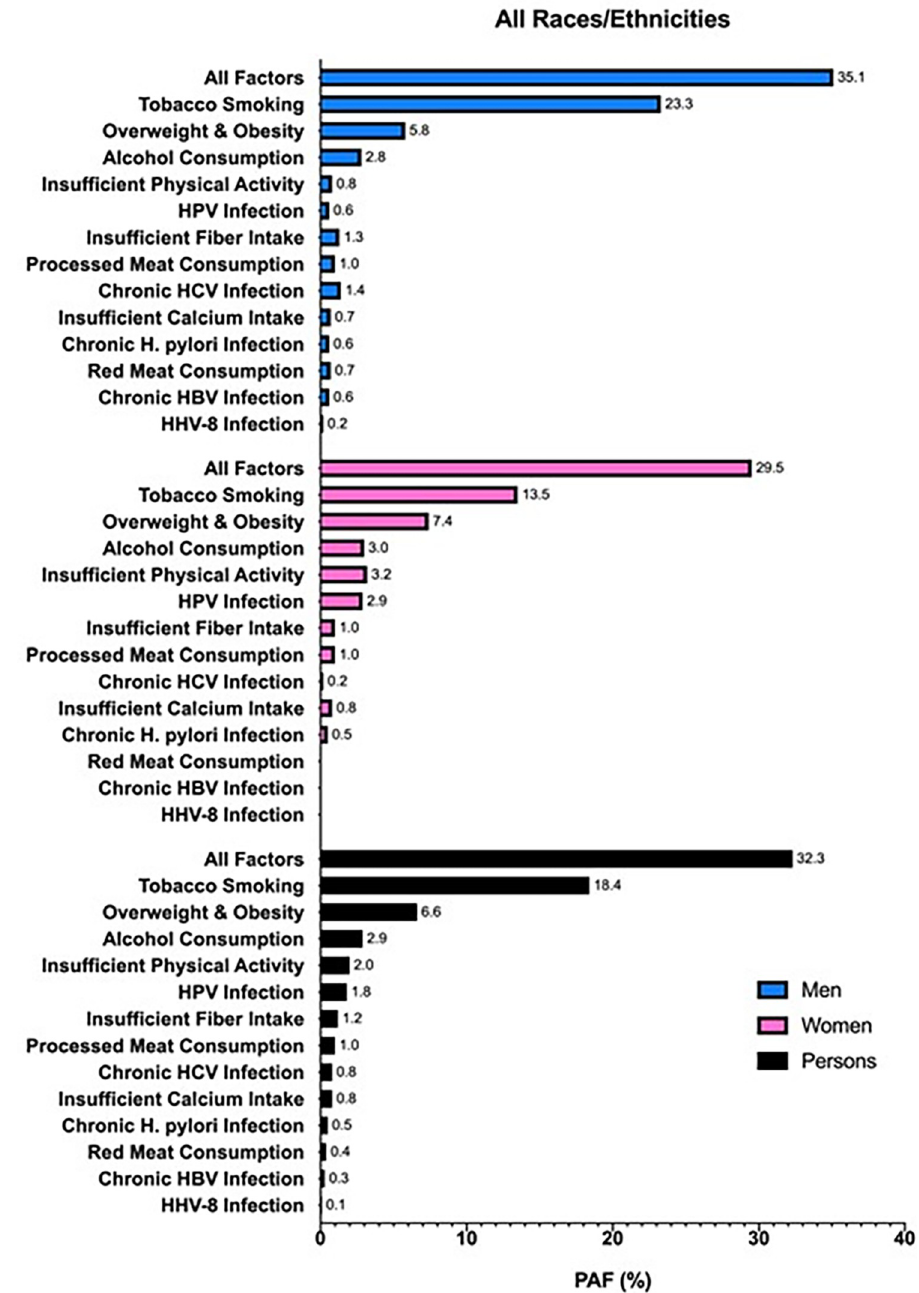
Fig 1. PAFs (%) of incident cancers attributable to modifiable risk factors in Texas in 2015 for men (blue), women (pink), and persons (black) of all races/ethnicities aged � 25 years. alcohol consumption, insufficient physical activity, HPV infection, and H . pylori infection caused more cancers in Hispanics, and tobacco smoking caused more cancers in non-Hispanic Whites than other racial/ethnic subgroups. There was no difference in overall PAF for red meat consumption across racial/ethnic groups. In men, tobacco smoking had the highest